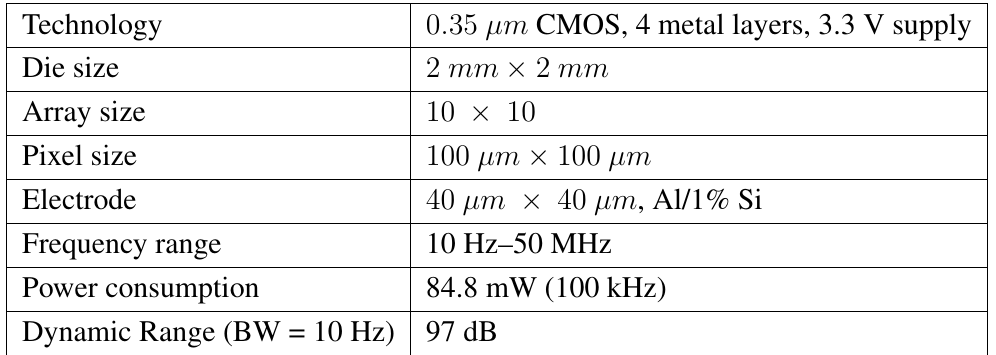
Table 1. Chip’s key